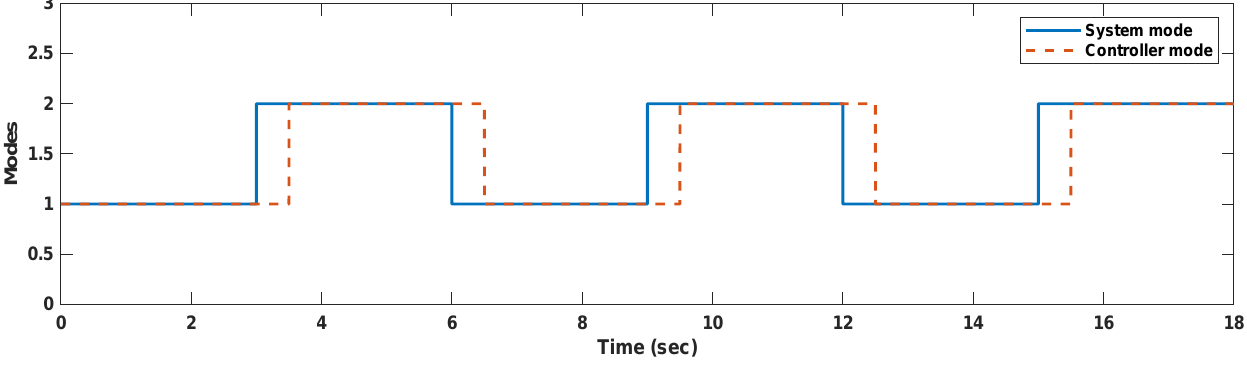
Figure 1. Example 1: Switching